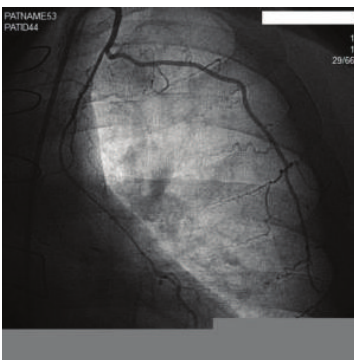
Figure 1: Patent hypoplastic LIMA with large thoracic side branch.